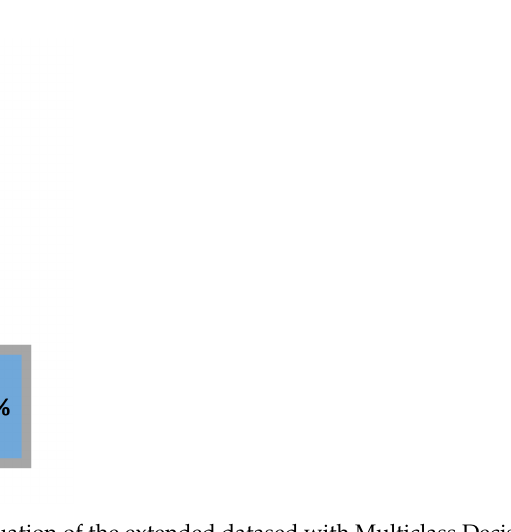
Figure 21. Confusion matrix from the evaluation of the extended datased with Multiclass Decission Forest, with eight decision trees.